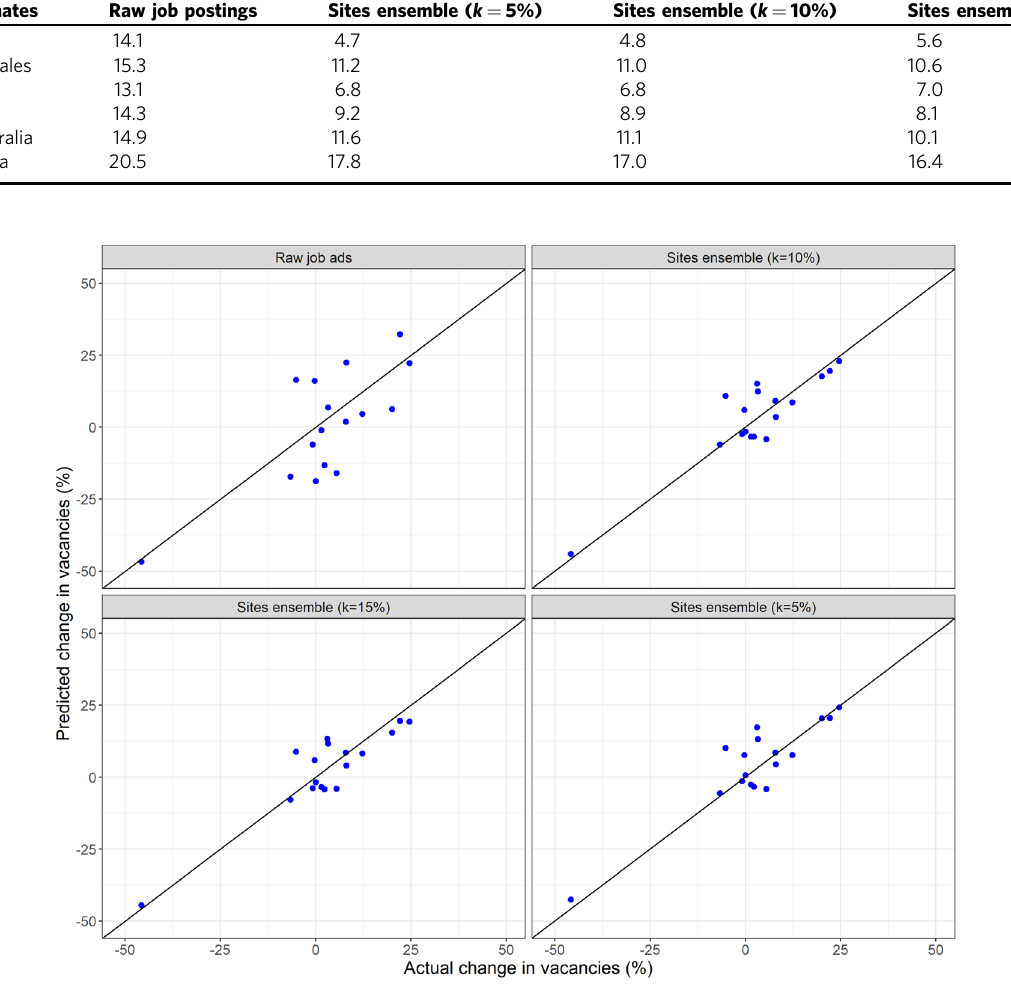
Fig. 4 Actual and predicted changes in vacancies. The change in job vacancies according to the Job Vacancy Survey and each method ’ s predicted change in vacancies across the 18 quarters in the test set at the Australia